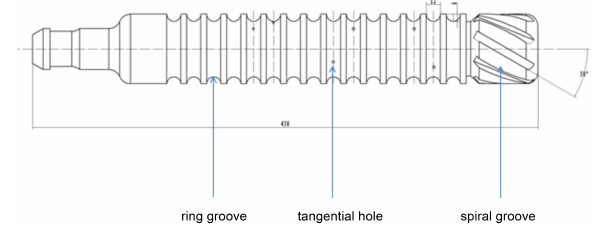
Fig. 4. Structure of rotating dynamic seal plunger.